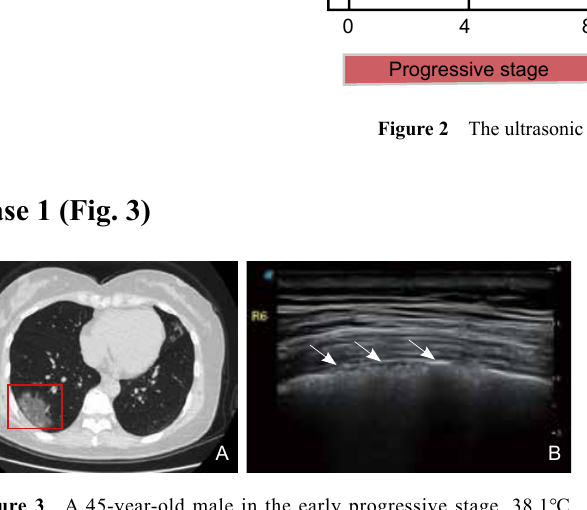
Figure 3 A 45-year-old male in the early progressive stage, 38.1℃ fever, no cough, no sputum, no dyspnea, positive with coronavirus swab test. Chest CT (A) showed patchy effusion of the right lower lung lobe. The Ultrasound (B) displayed the unsmooth pleura line at corresponding position (arrow).